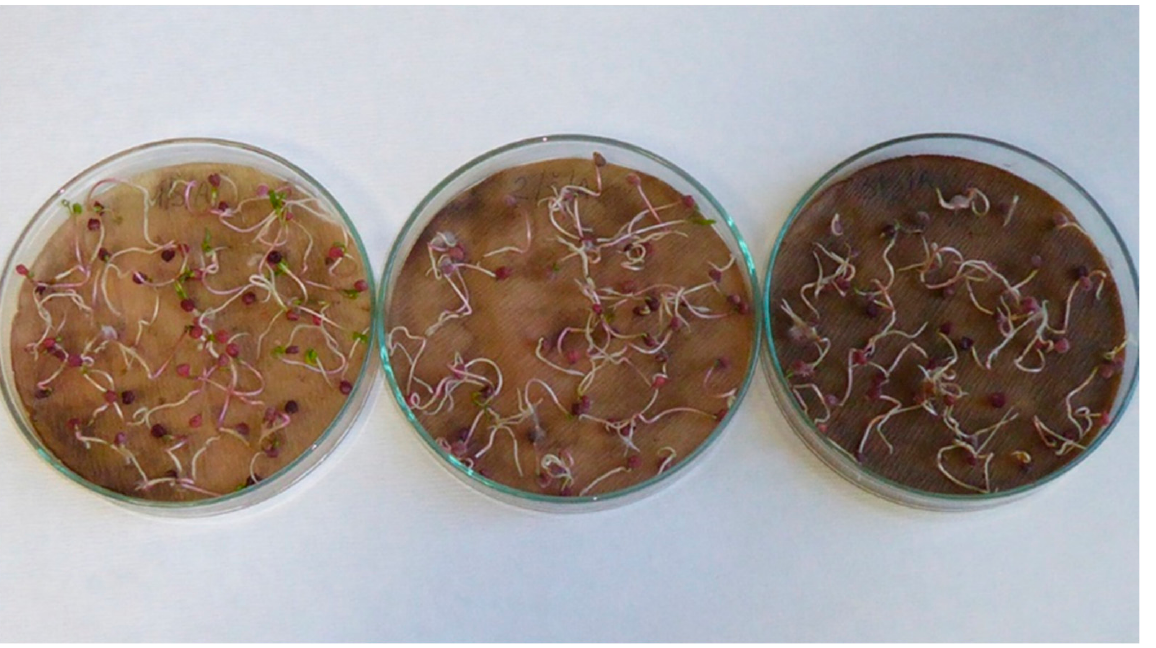
Figure A8. Spinach ( Spinacia oleracea L.) seedlings; treatments with aqueous extracts of nettle ( Urtica dioica L.) in 2.5% concentration ( left ), 5% concentration ( middle ) and 10% concentration ( right ).